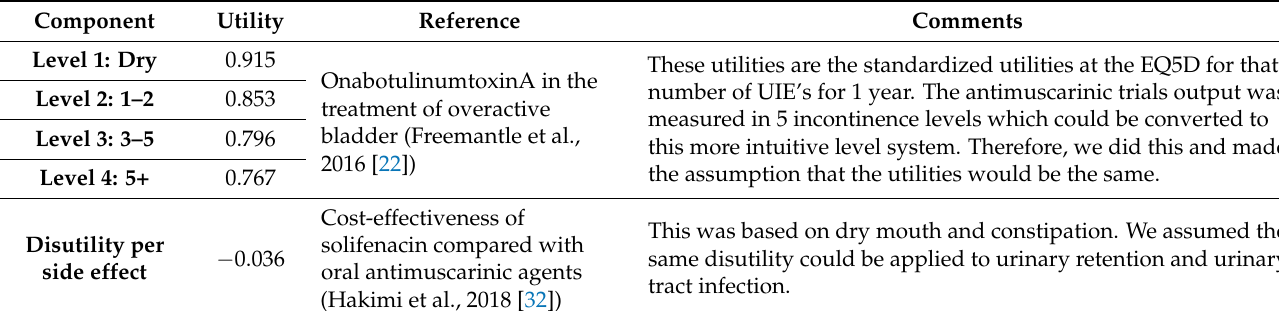
Table A7. Output Utilities.